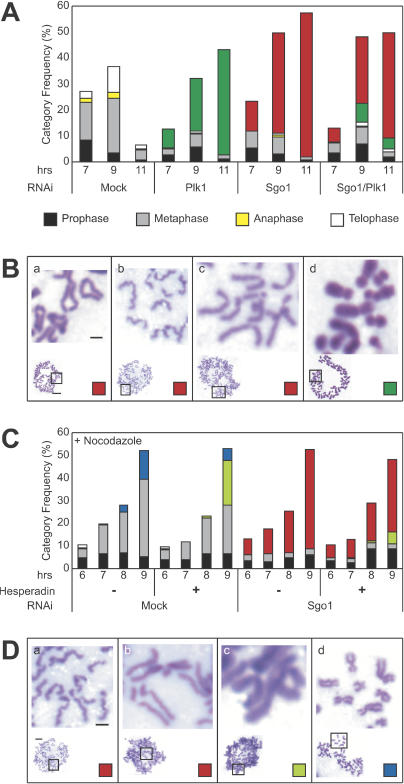
Neither Plk Depletion nor Aurora B Inhibition Suppresses the Precocious Sister Separation Seen in Sgo1-Depleted Cells(A and B) Synchronised HeLa cells were mock-treated or transfected with the indicated combination of Sgo1 and Plk1 siRNA and harvested at the time shown following release from thymidine block. Chromosomes were then spread on glass slides and examined by Giemsa staining. As in Figure 3, the percentage of mitotic cells were calculated out of 200 cells, and mitotic chromosome spreads were then further classified into one of 10 categories (n = 200 mitotic spreads for each time point). (A) The frequency of each category of mitotic cell (see examples in Figures 3B and 7B) is given as a percentage of total cell numbers, such that the sum of each column represents the mitotic index. (B) In addition to the seven categories in Figure 3A and 3B, the following categories (illustrated in Figure 7B) were scored: (a) sister centromeres separated, arms still cohesed; (b) scattered chromatids, same as Figure 3B, part g; (c) sisters are separated and randomly distributed in relation to one another, but are not hypercondensed; and (d) sister chromatids are cohesed along their length, and rod-shaped chromosomes are hypercondensed, as is characteristically seen with Plk1 knockdown [20]. For simplicity, the categories illustrated in Figure 3B, part e and f, and Figure 7B, part a–c, were combined into a single category representing premature sister separation (shown in red). In smaller pictures, bar = 10 μm; in enlarged portions, bar = 2 μm.(C and D) Synchronised HeLa cells were mock-treated or transfected as indicated. At 6 h after release from the second thymidine block, cells were treated with nocodazole with or without Aurora B inhibitor Hesperadin as indicated, and harvested at hourly intervals up to 3 h thereafter. Mitotic index and chromosome spreads were assessed as in (A). (C) The frequency of each category of mitotic cell (illustrated in Figures 3B and 7D) is given as a percentage of total cell numbers, such that the sum of each column represents the mitotic index. (D) The seven categories scored for Figure 3A and 3B were also scored for this experiment. (a) Scattered chromatids as in Figure 3B, part g; (b) early phase of precocious sister disjunction as in Figure 3B, part e. In addition the following categories (illustrated in Figure 7D) were also scored: (c) Chromosomes have begun to decondense prior to separation, and sister resolution is defective, characteristic of Hesperadin treatment. (d) Centromeres cohesed, and arms opened and hypercondensed, characteristic of nocodazole treatment.